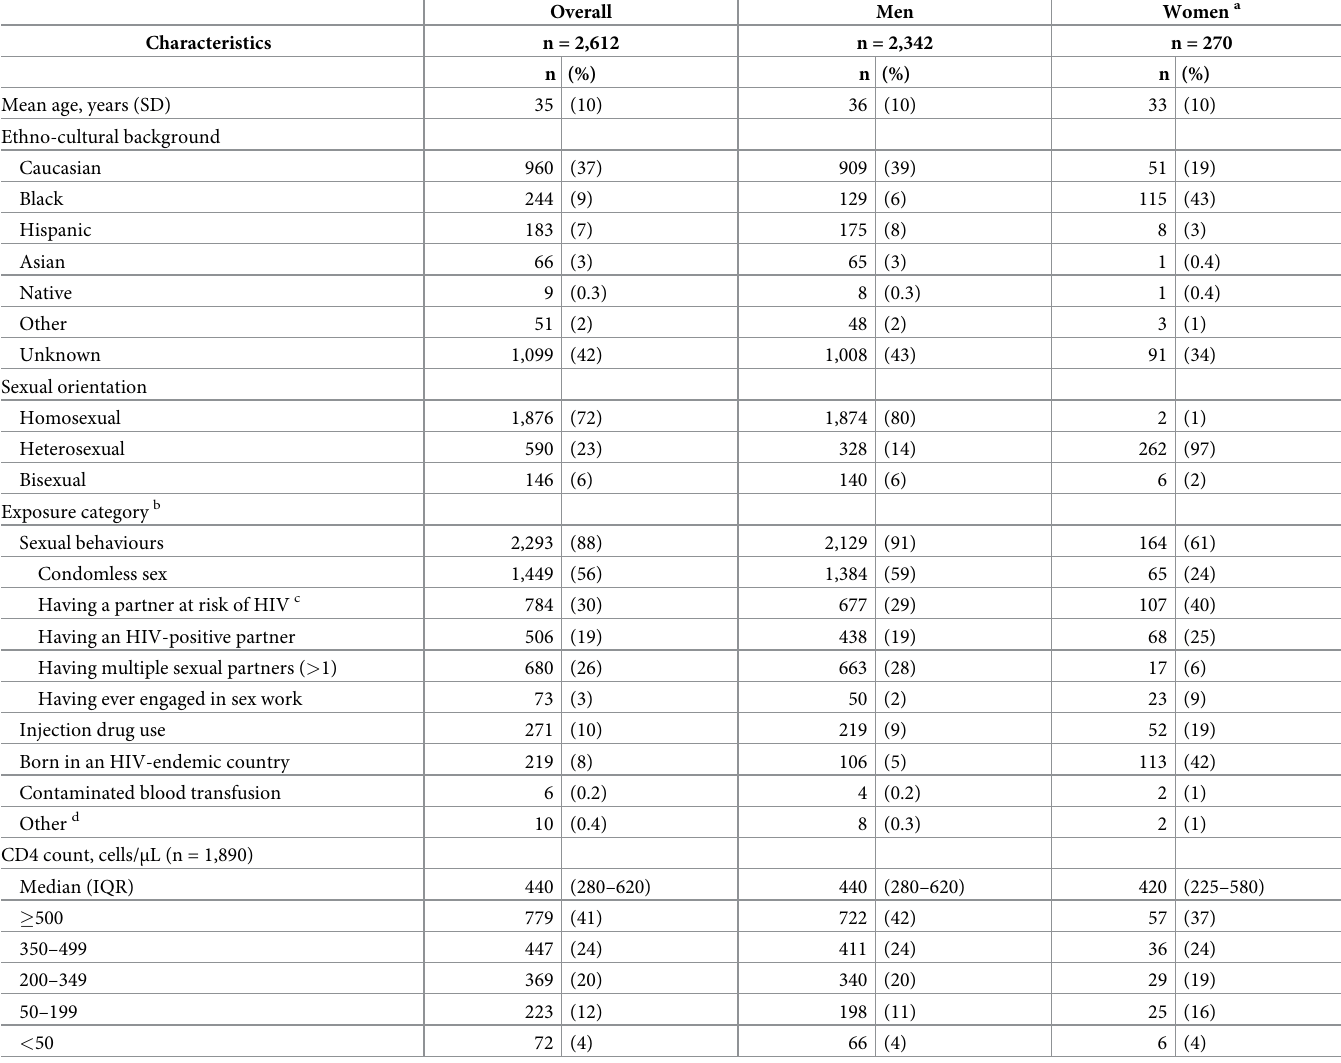
Table 1. Characteristics of patients at HIV diagnosis among participants to the HIV-positive cohort at the Clinique médicale l’Actuel in Montre´al (Canada), strati- fied by gender (n = 2,612), 1995–2019. Overall Men Women